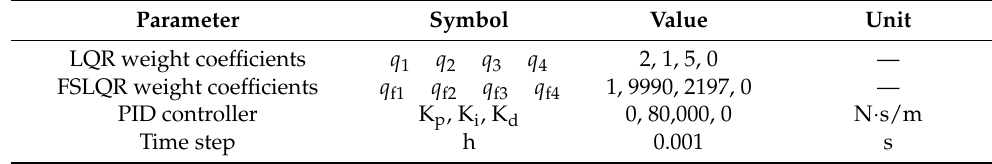
Table 2. The parameters of the full state LQR